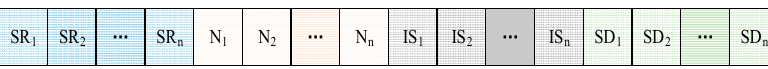
Figure 4. The individual parameter structure of the echo state network (ESN).